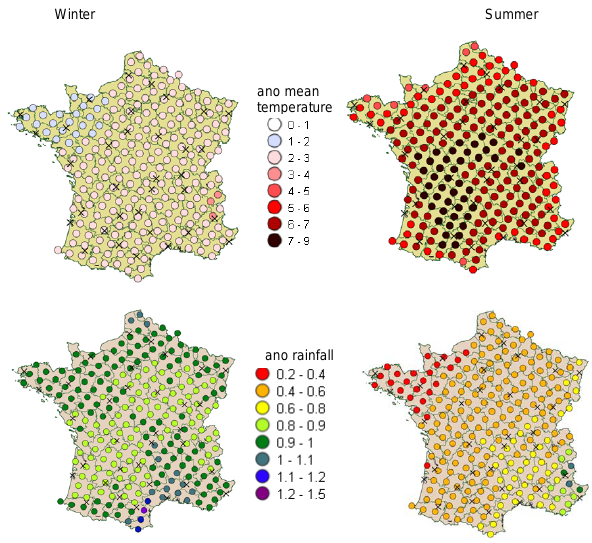
Figure 1. Seasonal anomalies for temperature and rainfall in the distant future (A2 scenario) in winter and summer: mean values of di ff erences (future-present) for temperature(in ◦ C), ratio (fu- ture / present) for rainfall (no change = 1) for the season.